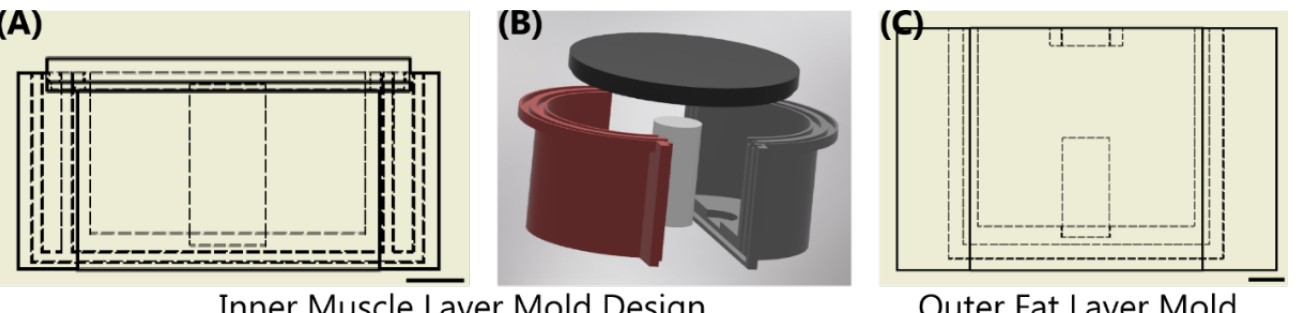
Figure 1. Overview of Sequential Mold Setup. ( A,B ) The inner muscle mold was comprised of 4 components shown as a ( A ) cross-sectional view with inner dimensions shown as dashed lines and ( B ) in exploded view. Two shells were snapped together with an inner bone; top lid was assembled after the phantom solution was added. ( C ) The outer fat layer mold shown with the same bone in the middle of the drawing. Scale bars denote 20 mm.